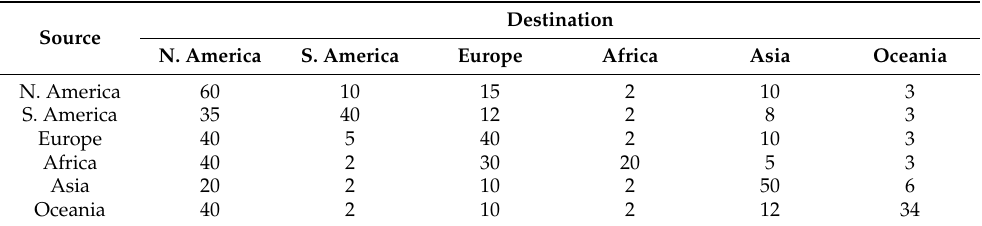
Table 5. Distribution of Traffic Flows